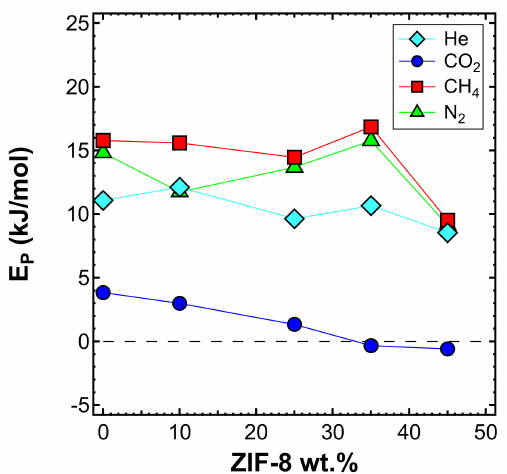
Figure 15. Activation energy of permeability as measured in the interval 35–65 ◦ C for four gases in the various MMMs inspected, as a function of filler